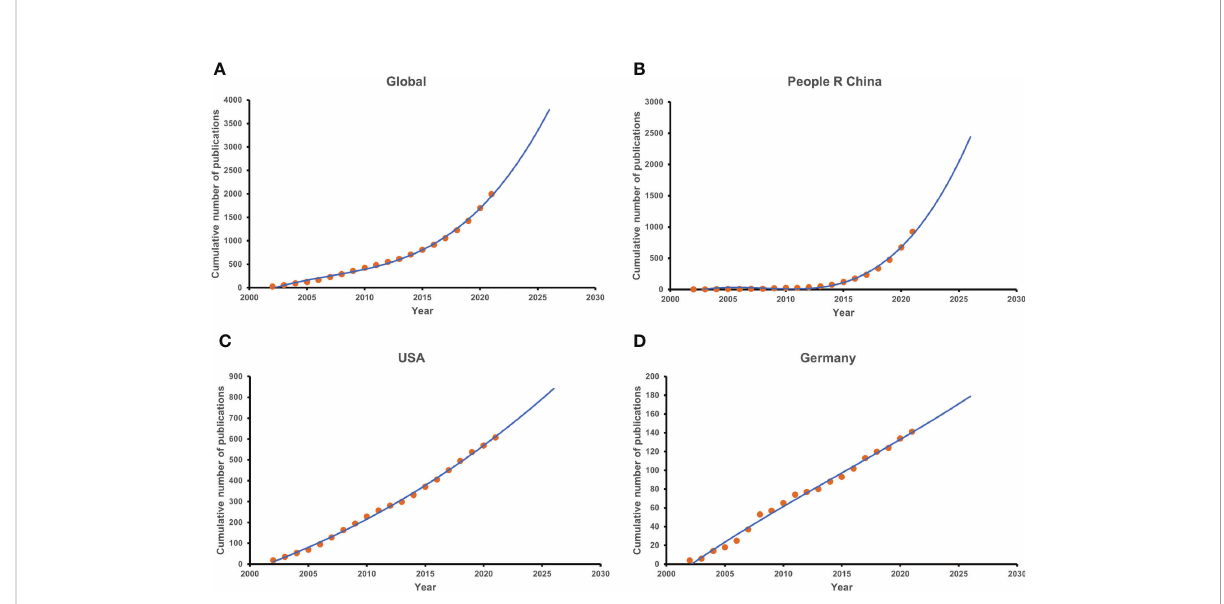
FIGURE 4 The model fi tting curves of growth trends with regard to sepsis and programmed cell death. (A) Global. (B) The People ’ s Republic of China. (C) The United States. (D)